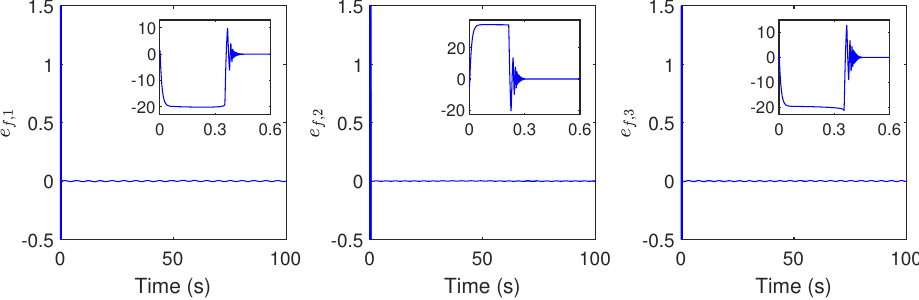
Figure 12. Fault estimation errors for the distributed SMOs when u d , i = 0 for i = 1,2,3.